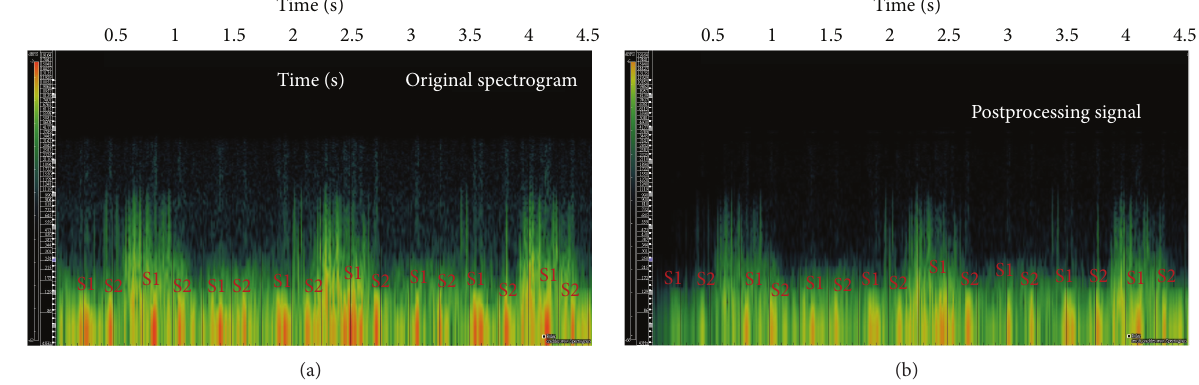
Figure 6: (a) The spectrogram of crackles with audible heart sounds. (b) The spectrogram after processing.